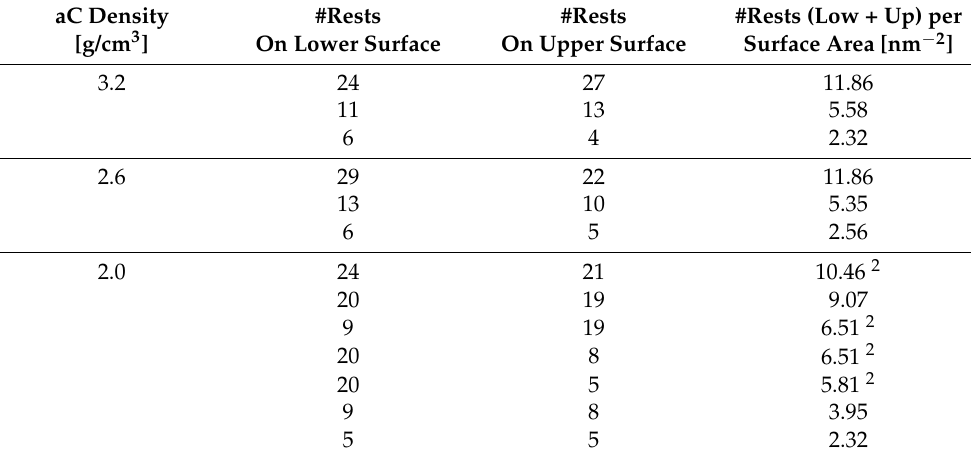
3 alcohol), -OH, and –H 1